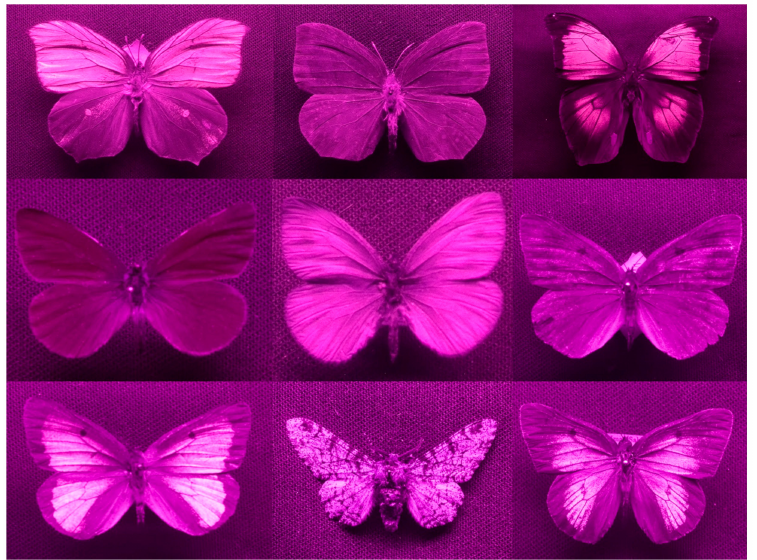
Figure 3. A relatively large proportion of studies fails to consider the widespread UV phenomena and many researchers neglect the UV spectrum as part of the integrated visual